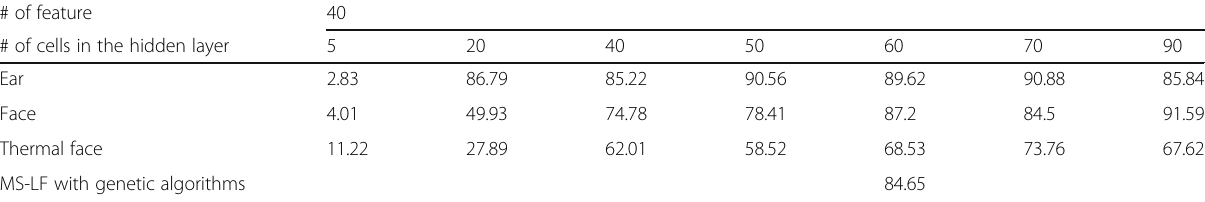
Table 3 Matching score-level fusion with eigenfeatures (#feature 40) # of feature